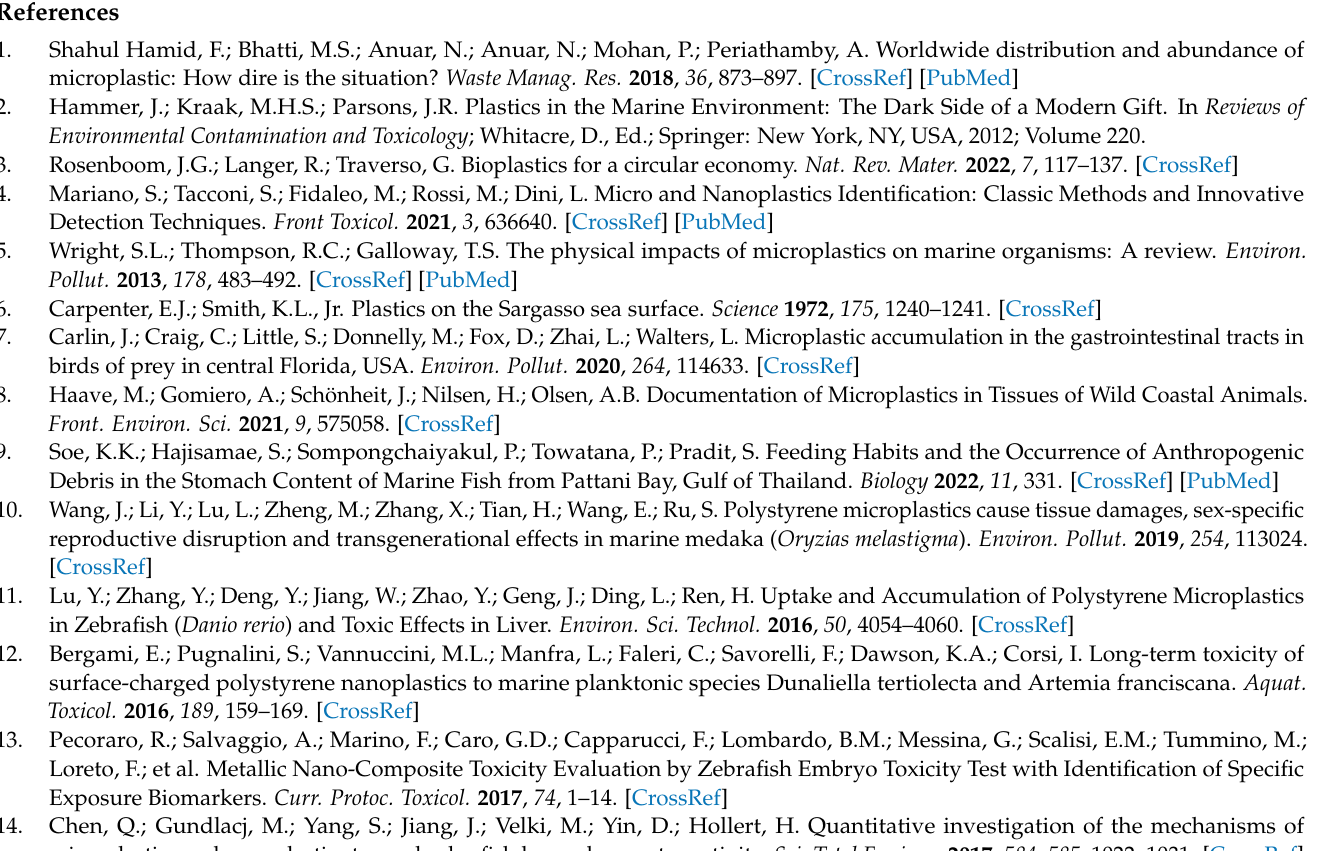
S2: Summarized table of all tested parameters, expressed as mean ± standard deviation. ** indicates statistically significant differences ( p < 0.05). Figure S3: Crystallized structure of D. rerio receptors with visible Pockets. (A) Receptor for retinol uptake stra6 (STRA6) with 2D and 3D visions of Pockets 1 and 2; (B) adhesion G protein–coupled receptor G6 (Adgrg6; also named GPR126) with 2D and 3D visions of Pockets 1, 3, 2 and 5; (C) contactin 4 (CNTN4) and amyloid beta precursor like protein 2 (APLP2) complex with 2D and 3D visions of Pockets 1 and 3. Table S3: Affinity of nPS-NPs toward the pockets of STRA6, GPR126 and CNTN4/APLP2 receptors, based on potential bonding types (summarized through Glob-Sum) and pocket